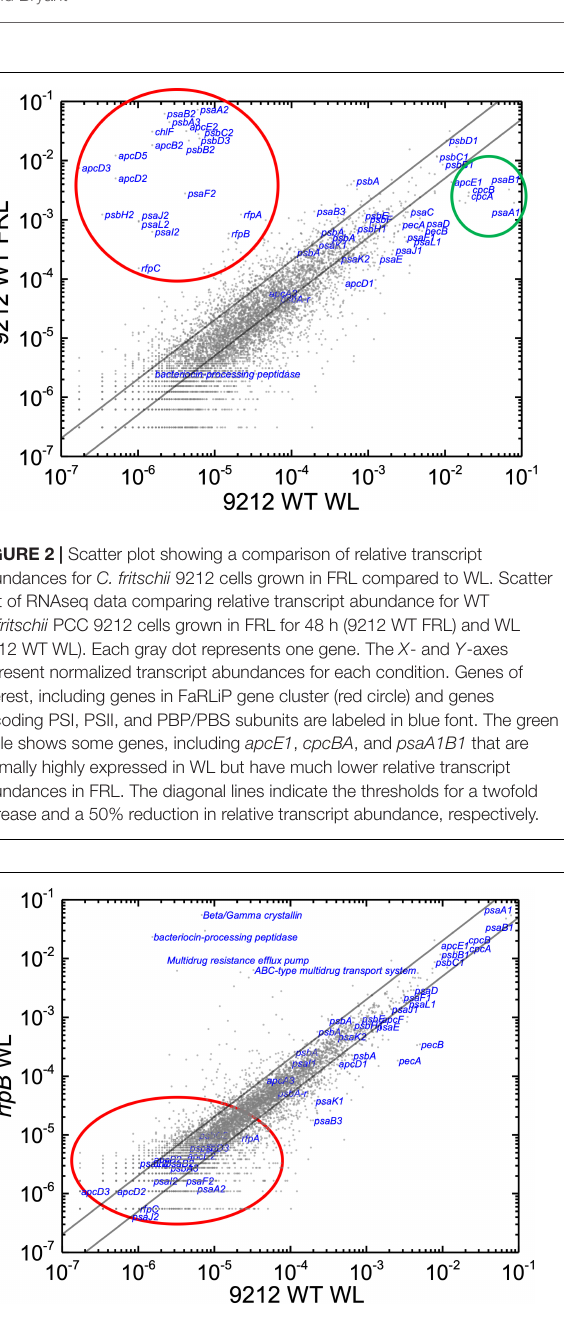
FIGURE 3 | Scatter plot showing a comparison of relative transcript abundances in cells of the rfpB mutant and WT strains of C. fritschii 9212 grown in WL. The X - and Y -axes represent normalized transcript abundances in the rfpB mutant and the WT grown in WL, respectively. Each gray dot represents one gene. Genes of interest, including genes in FaRLiP gene cluster (red oval) and genes encoding PSI, PSII, and PBP/PBS subunits are labeled in blue. The diagonal lines indicate the thresholds for a twofold increase and a 50% reduction in relative transcript abundance, respectively.